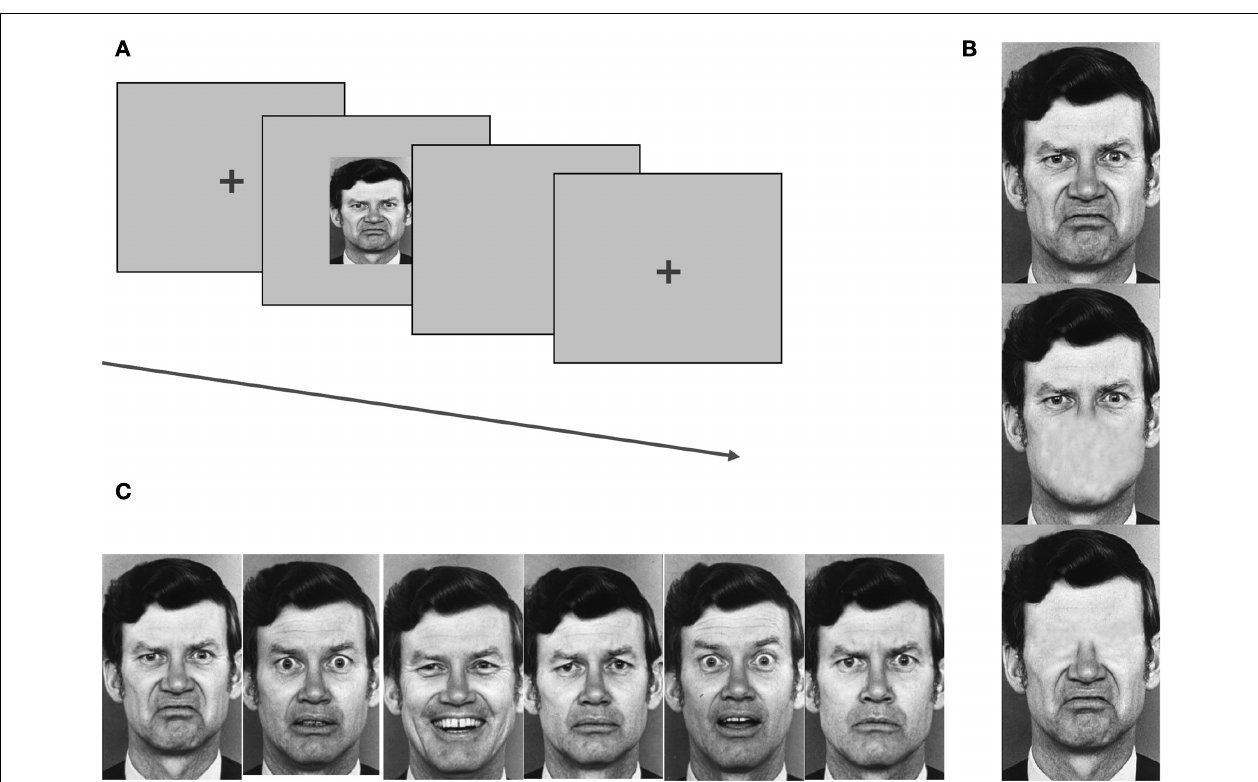
FIGURE 1 | Example of the forced-choice emotion recognition task: (A) task design; (B) example of the three experimental conditions (complete face condition, eyes-only condition, and mouth-only condition); (C) example of the six basic emotions that were used.